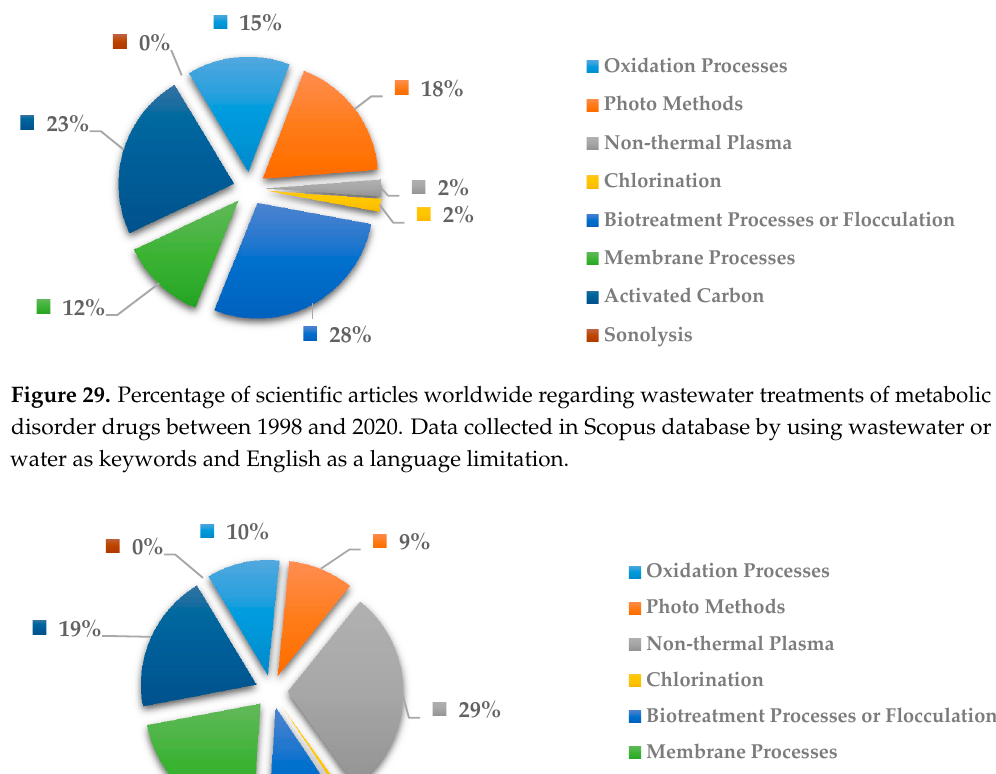
Figure 28. Percentage of scientific articles worldwide regarding wastewater treatments of psychiatric-neurological drugs between 1998 and 2020. Data collected in Scopus database by using wastewater or water as keywords and English as a language limitation.